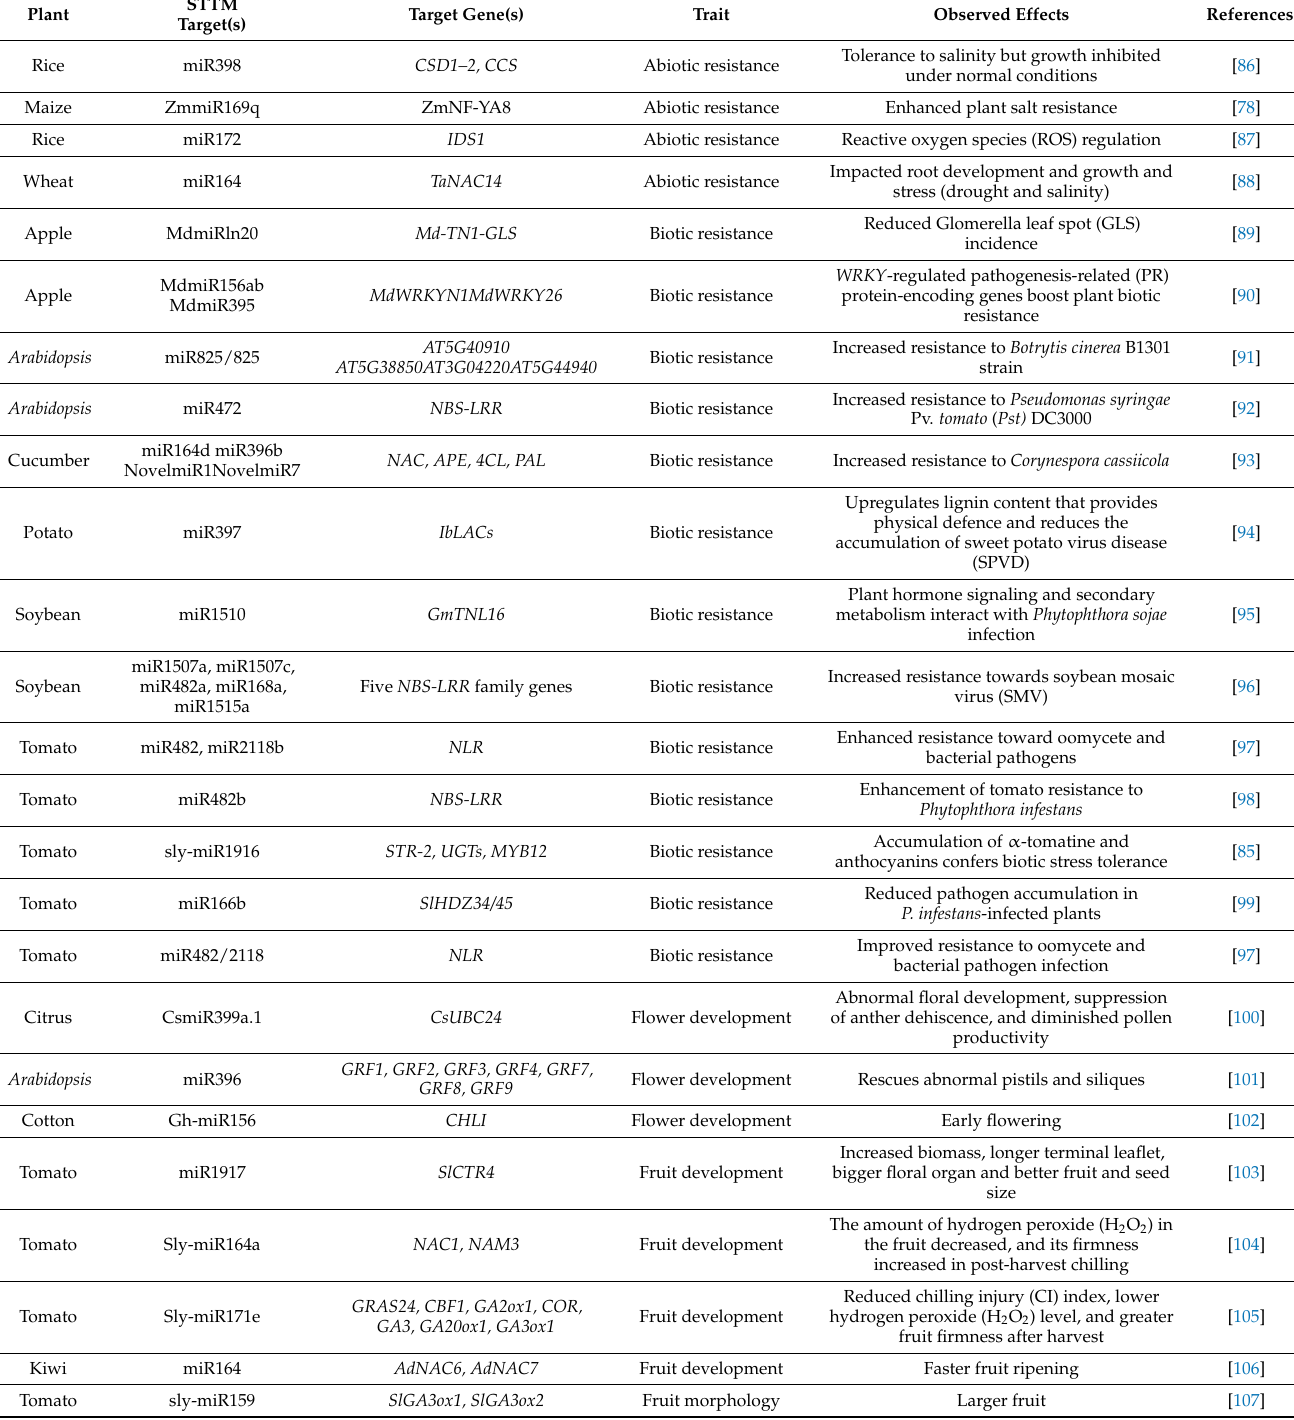
Table 2. Diverse plant species and STTM targets for miRNA functional